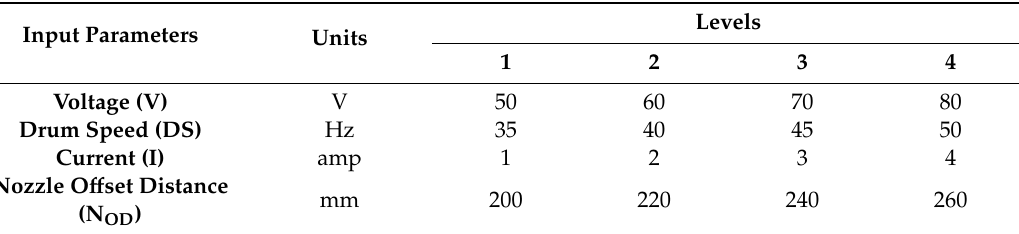
Table 2. Input parameters and their